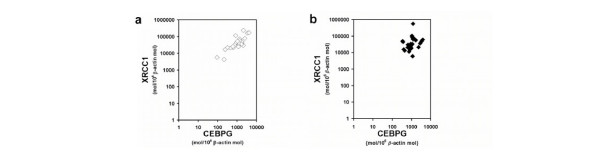
Scatter plot representation of bivariate correlation of CEBPG with XRCC1. (a, b) CEBPG/XRCC1 data from Figure 1b presented as scatter plots: (a) non-BC individuals, (b) BC individuals.